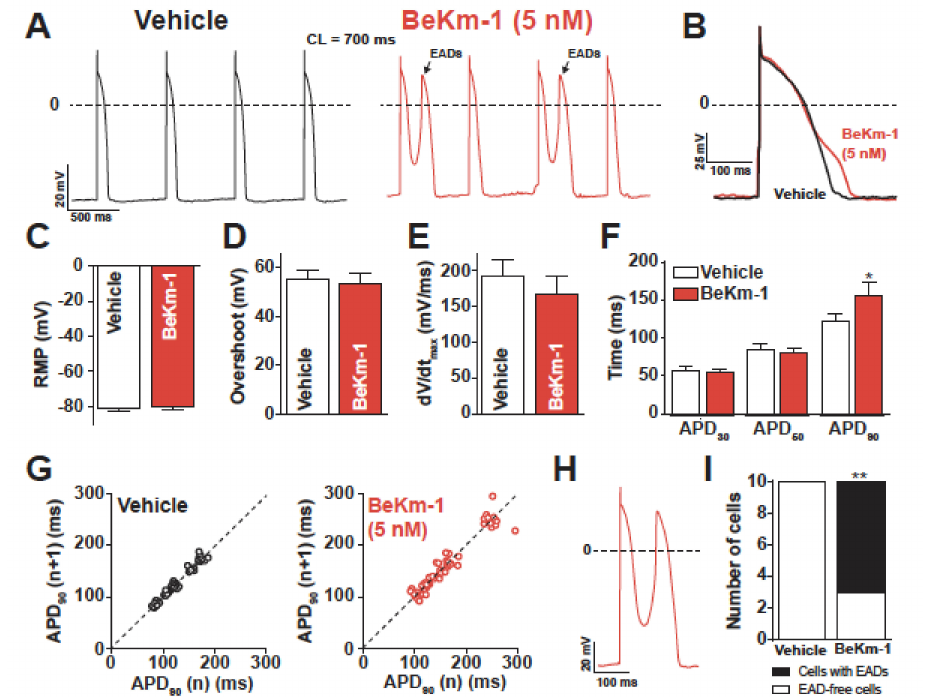
Figure 3. BeKm-1 mainly a ff ects the late phase of repolarization in dynamically clamped hiPS-CMs and induces cellular arrhythmic events. ( A ) Representative APs paced at 1.4 Hz with I K1 before (black trace) and with 5 nM BeKm-1 application (red trace). Note the presence of early afterdepolarizations (EADs) in BeKm-1 treated cells (black arrows). ( B ) Superimposed APs raw traces of a ventricular-like cardiomyocyte before and after application of 5 nM BeKm-1 showing delayed repolarization. ( C – F ) Average e ff ects of 5 nM BeKm-1 on RMP (C), overshoot (D), maximal upstroke velocity (E), and APDs at 30%, 50%, and 90% of repolarization (F). ( G ) Poincar é plots showing APD 90 variability from consecutive APs before (left panel) and after (right panel) treatment with 5 nM BeKm-1. ( H ) Expanded representative AP showing the occurrence of an EAD during application of 5 nM BeKm-1. ( I ) Number of cells displaying EADs in both conditions. n = 14 cells for all panels. Paired t-tests with *, p < 0.05; **, p < 0.01. Fisher